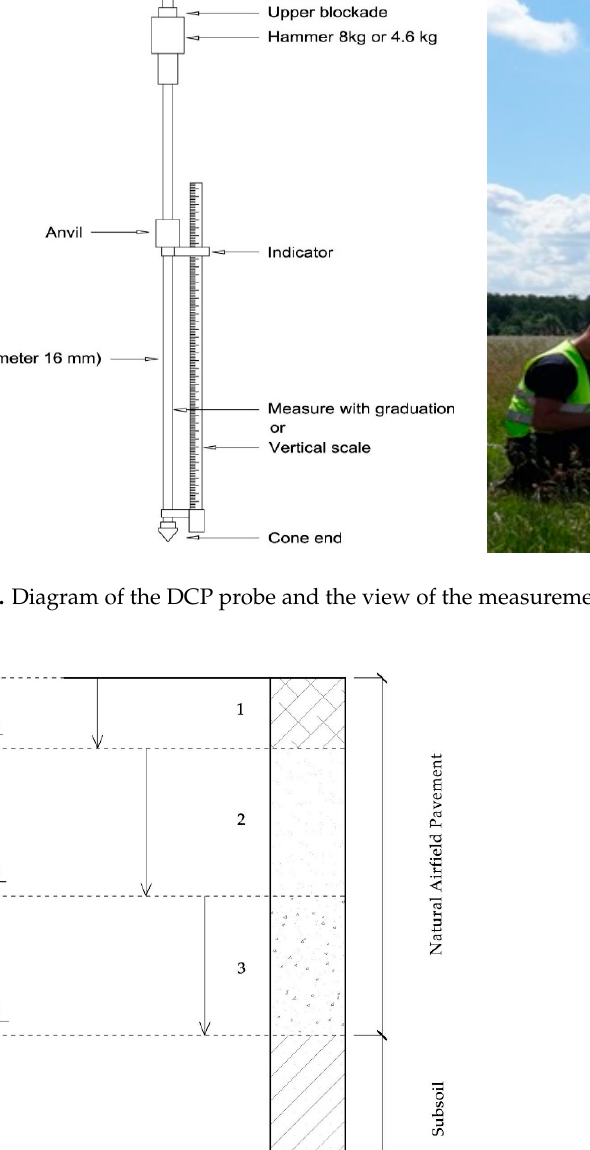
Figure 7. The structure of separated layers of the natural airfield pavement: 1—first layer, up to a depth of 0.15 m; 2—second layer, from the depth of 0.15 m to the depth of 0.50 m; 3—the third layer, from a depth of 0.50 m to a depth of 0.85 m [34].